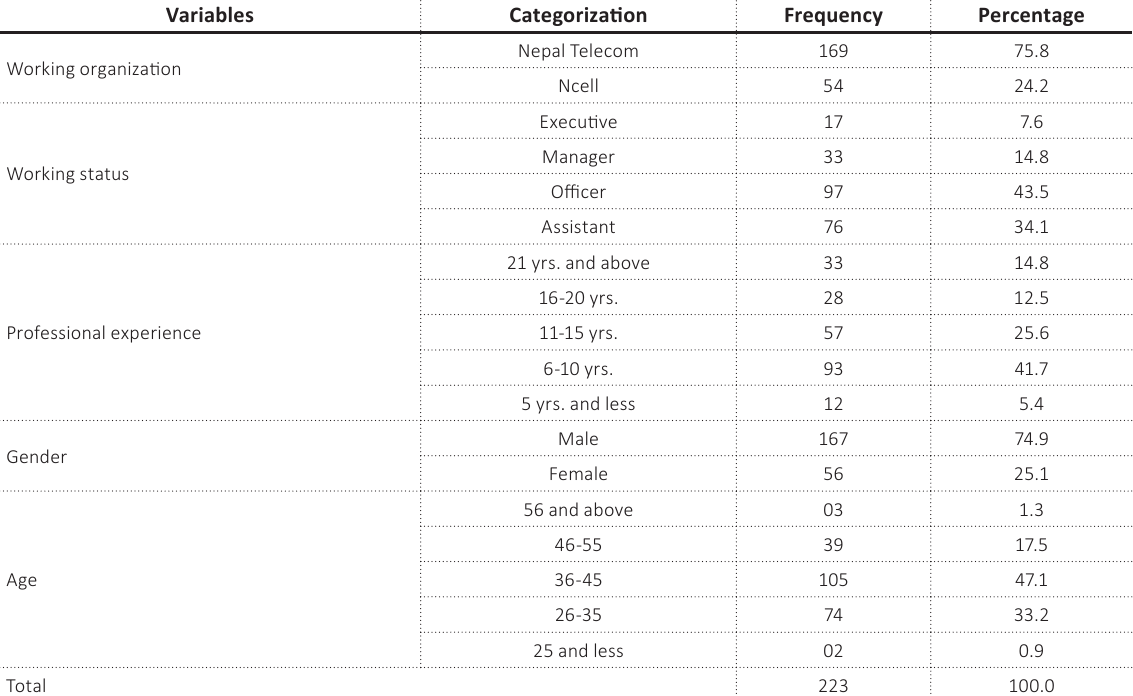
Table 4. Occupational and personal characteristics of the respondents